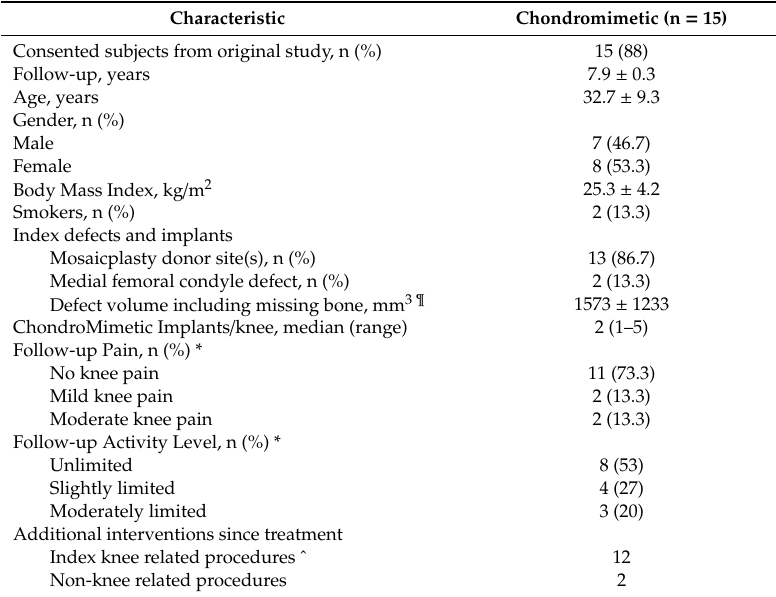
Table 1. Follow-up Characteristics of Trial Subjects ‡